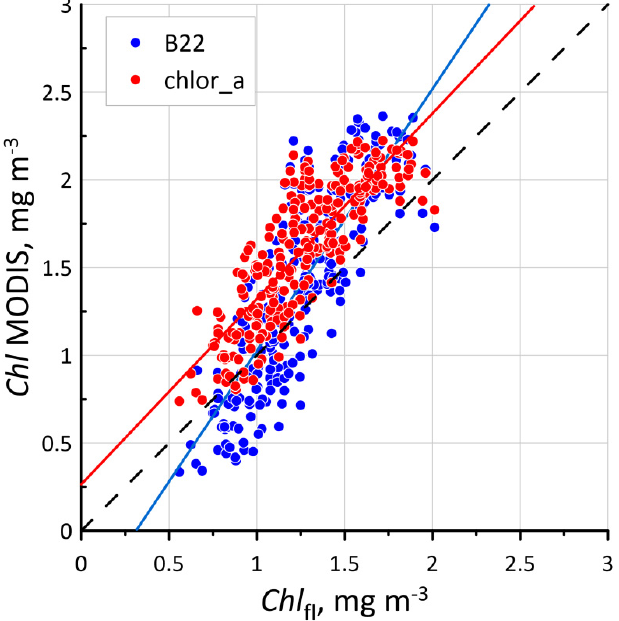
Figure 4. Comparison of Chl values calculated based on satellite data obtained on 14–15 August, 2017 and measured using a flow-through fluorimeter. The dashed line is the perfect fit (1:1), and the colored lines are linear regressions.